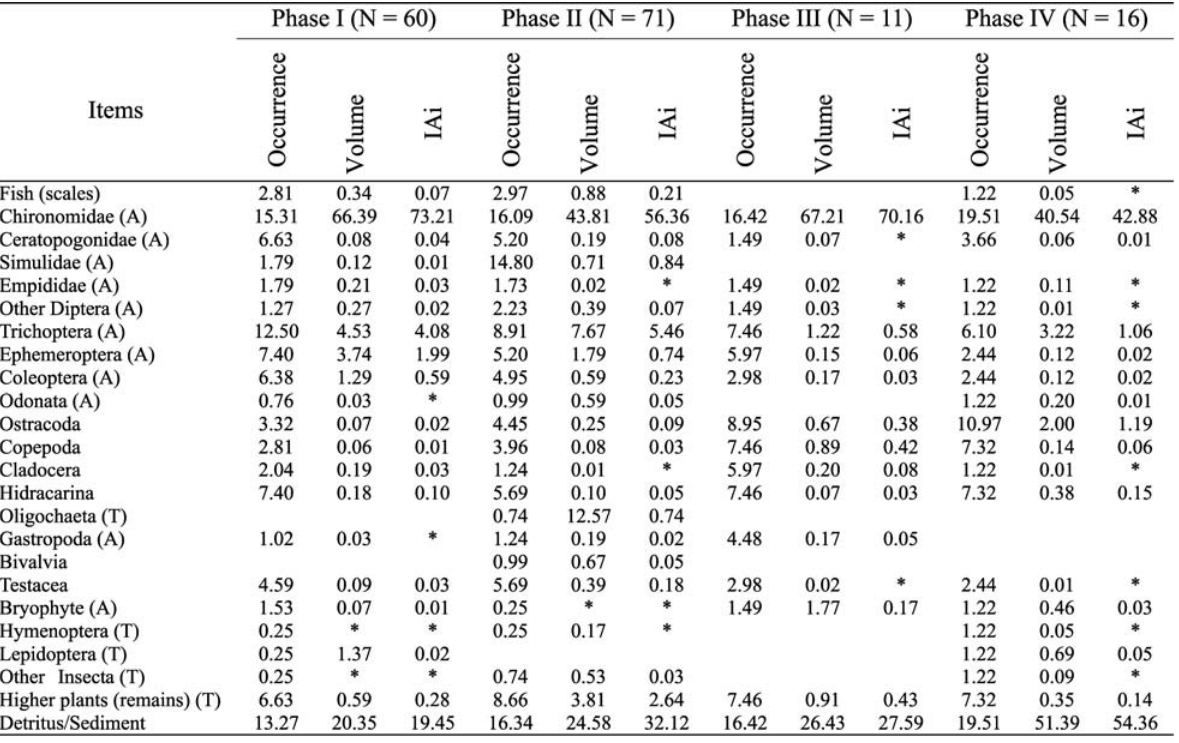
Table 1. Occurrence (%), Volume (%) and Feeding Index (IAi%) of the food items in the diet of Leporinus amblyrhynchus , before, during and after damming of the rio Corumbá, Goiás, Brazil. * Values smaller than 0.01. Values in parentheses indicate the number of stomachs contents. A= Aquatic; T=